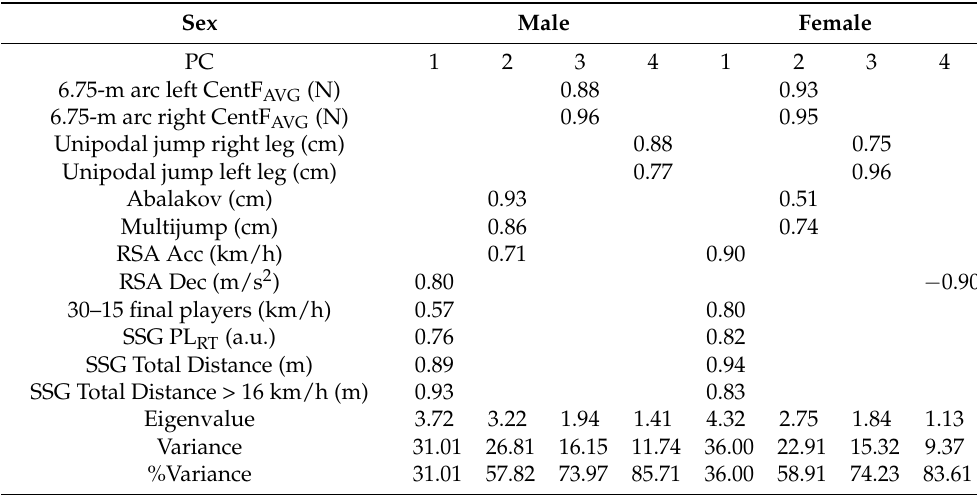
Table 2. Principal component analysis by sex with respective eigenvalue, variances and % variance